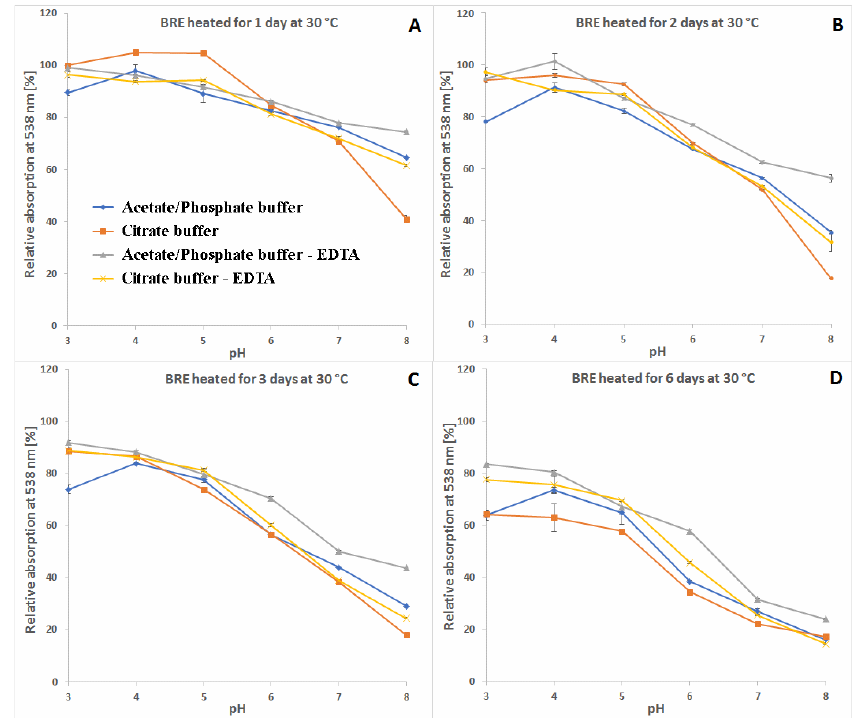
Figure 4. Relative absorption of red-violet pigments monitored at λ 538 nm after 1 ( A ), 2 ( B ), 3 ( C ) and 6 days ( D ) of heating (30 °C) of betalain-rich extract (related to its starting value before heating) in acetate/phosphate and citrate buffers with optional addition of EDTA.